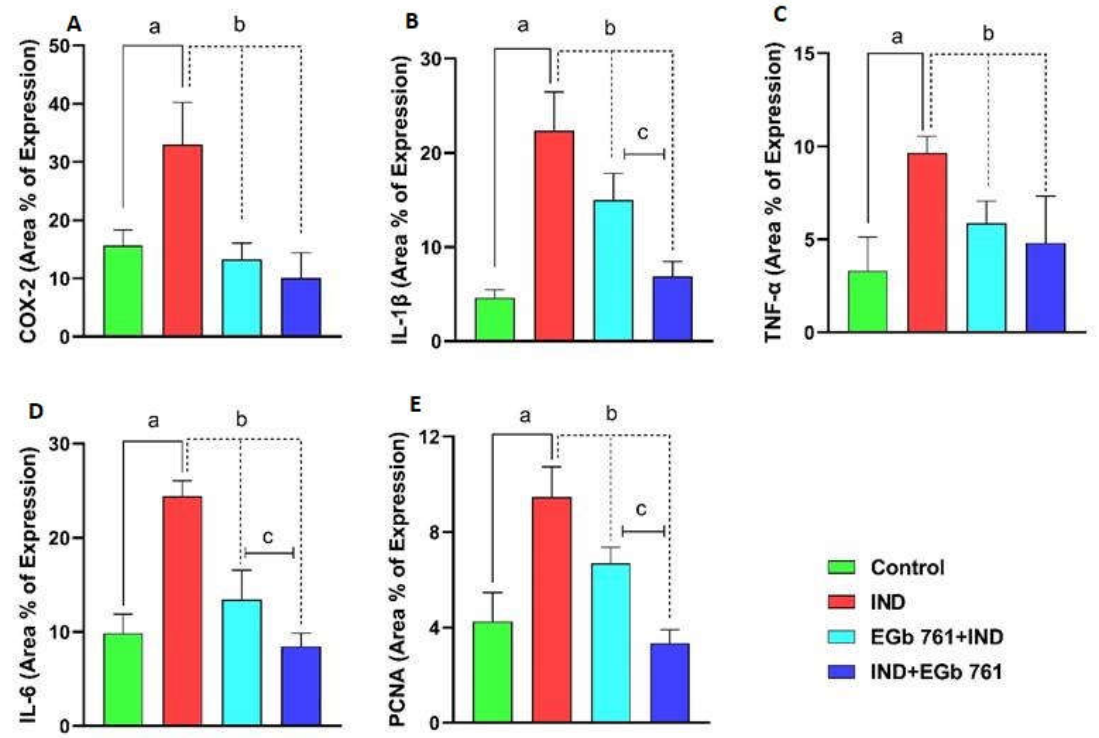
Figure 10. Area percentage values with statistical analysis regarding the expression of COX-2 ( A ), IL-1β ( B ), TNF-α ( C ), IL-6 ( D ), and PCNA ( E ) on immunohistochemical investigations of gastric mucosa in different groups. COX-2: Cyclooxy- genase-2; IL-1β: Interleukin-1beta; TNF-α: Tumor necrosis factor-alpha; IL-6: Interleukin-6; PCNA: Proliferating Cell Nu- clear Antigen. A high area percentage of expression values is noticed in the IND group (ulcer group). Prophylactic (EGb 761+IND) and therapeutic EGb 761 (IND+EGb 761) were associated with a dramatically low area percentage of expression. IL-1β, IL-6, and PCNA expressions were lower in therapeutic EGb 761 group when compared to prophylactic EGb 761. a : significant difference from control animals; b : significant difference from ulcer group; c : significant difference from prophylactic EGb 761